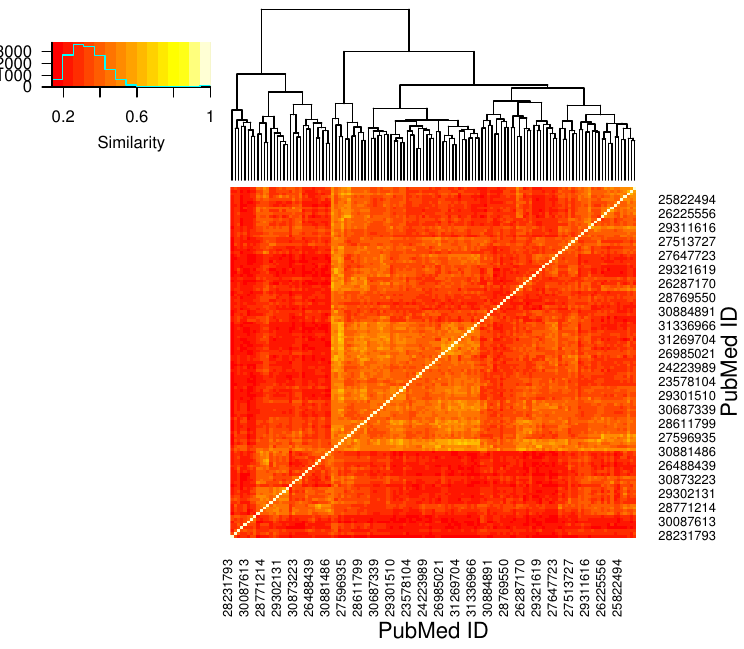
Figure 8. Heatmap showing the similarity between all articles in the data set, together with an histogram indicating how many article pairs exist with a concrete